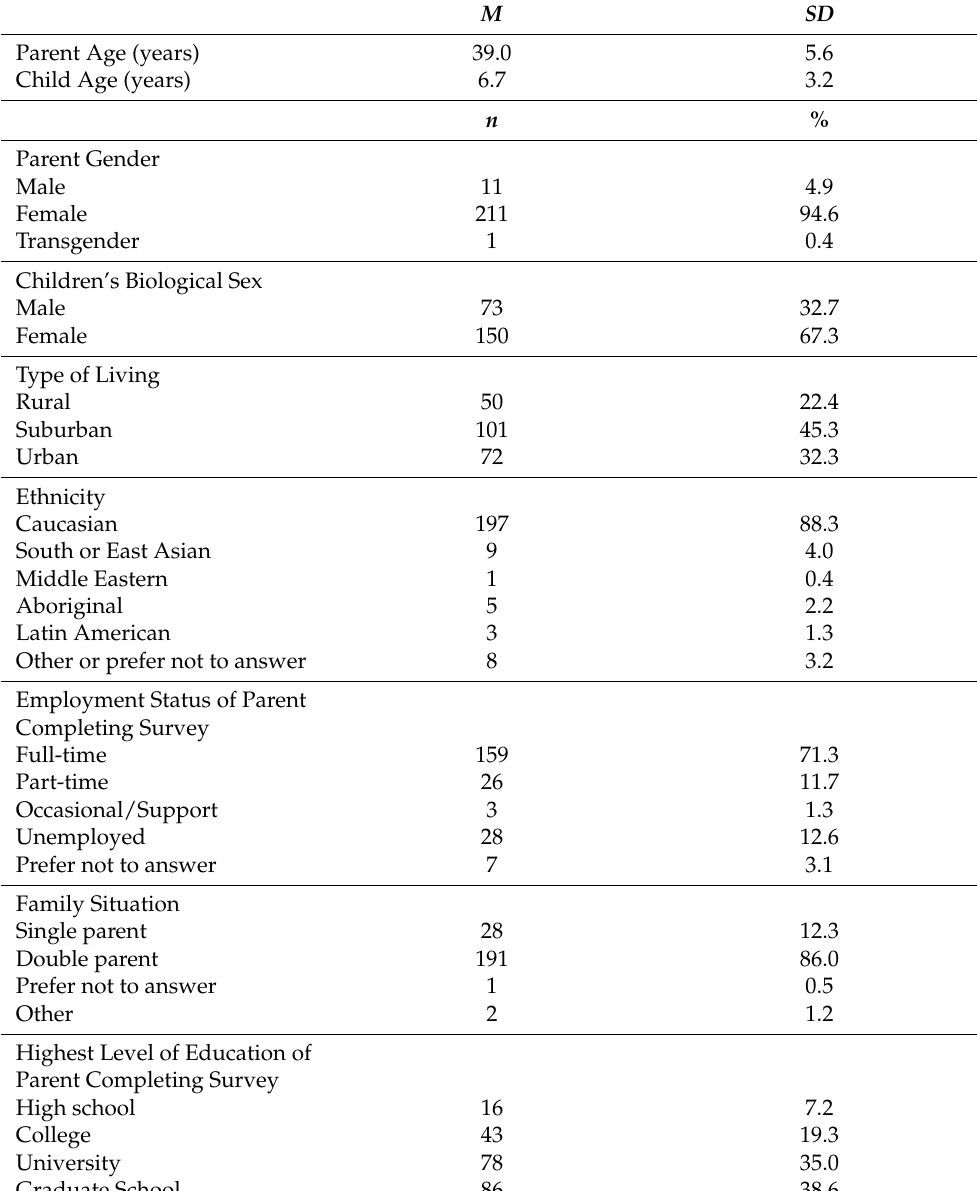
Table 1. Participant Demographics (n =